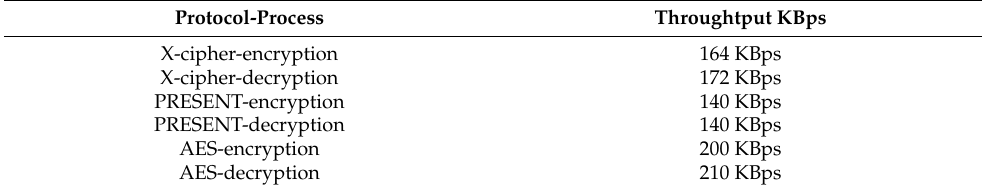
Table 4. Throughput results comparison between X-cipher and PRESENT.